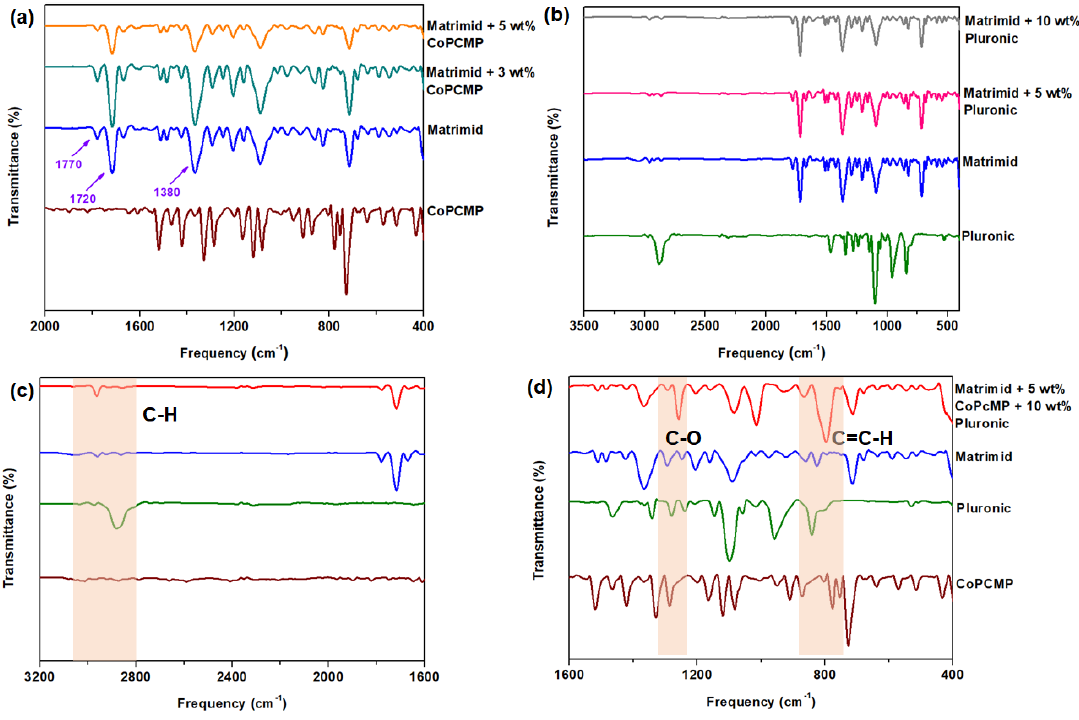
Figure 2. Fourier transform infrared (FTIR) spectra of ( a ) CoPCMP-based membranes and ( b ) Pluronic-based membranes; ( c , d ) FTIR spectra of CoPCMP, Pluronic ® F-127 (Pluronic), Matrimid ® 5218 (Matrimid), and composite (Matrimid-Pluronic-CoPCMP) containing 5 wt.% CoPCMP and 10 wt.% Pluronic. The shift in absorption bands in ( c , d ) are indicated for easy comparison.